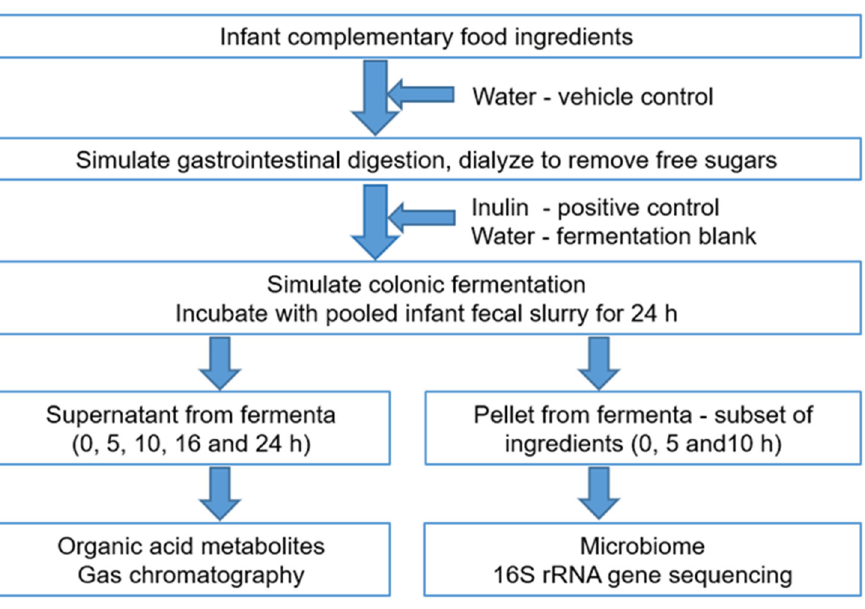
Figure 1. An outline of the experimental protocol and